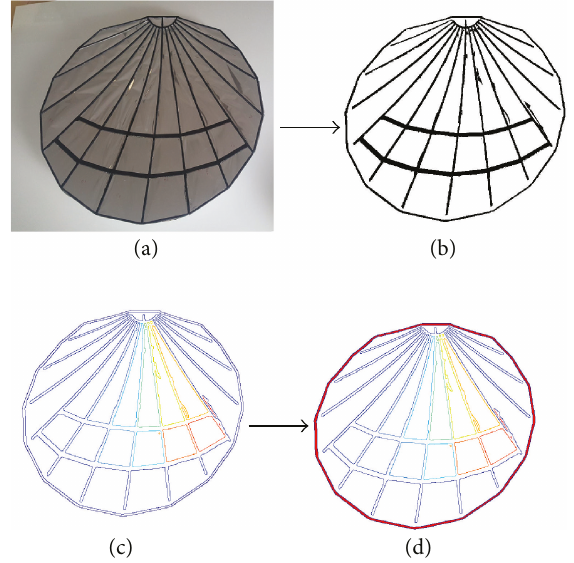
Figure 10: An example of the fl owchart of the dish edge detection process. (a) The acquired image is binarized. (b) The intersections between the ribs of the dish with the dish are “ cleaned. ” (c) Detecting the connected components in the binarized image is exempli fi ed. (d) The edge of the dish is then located by fi nding the resultant convex